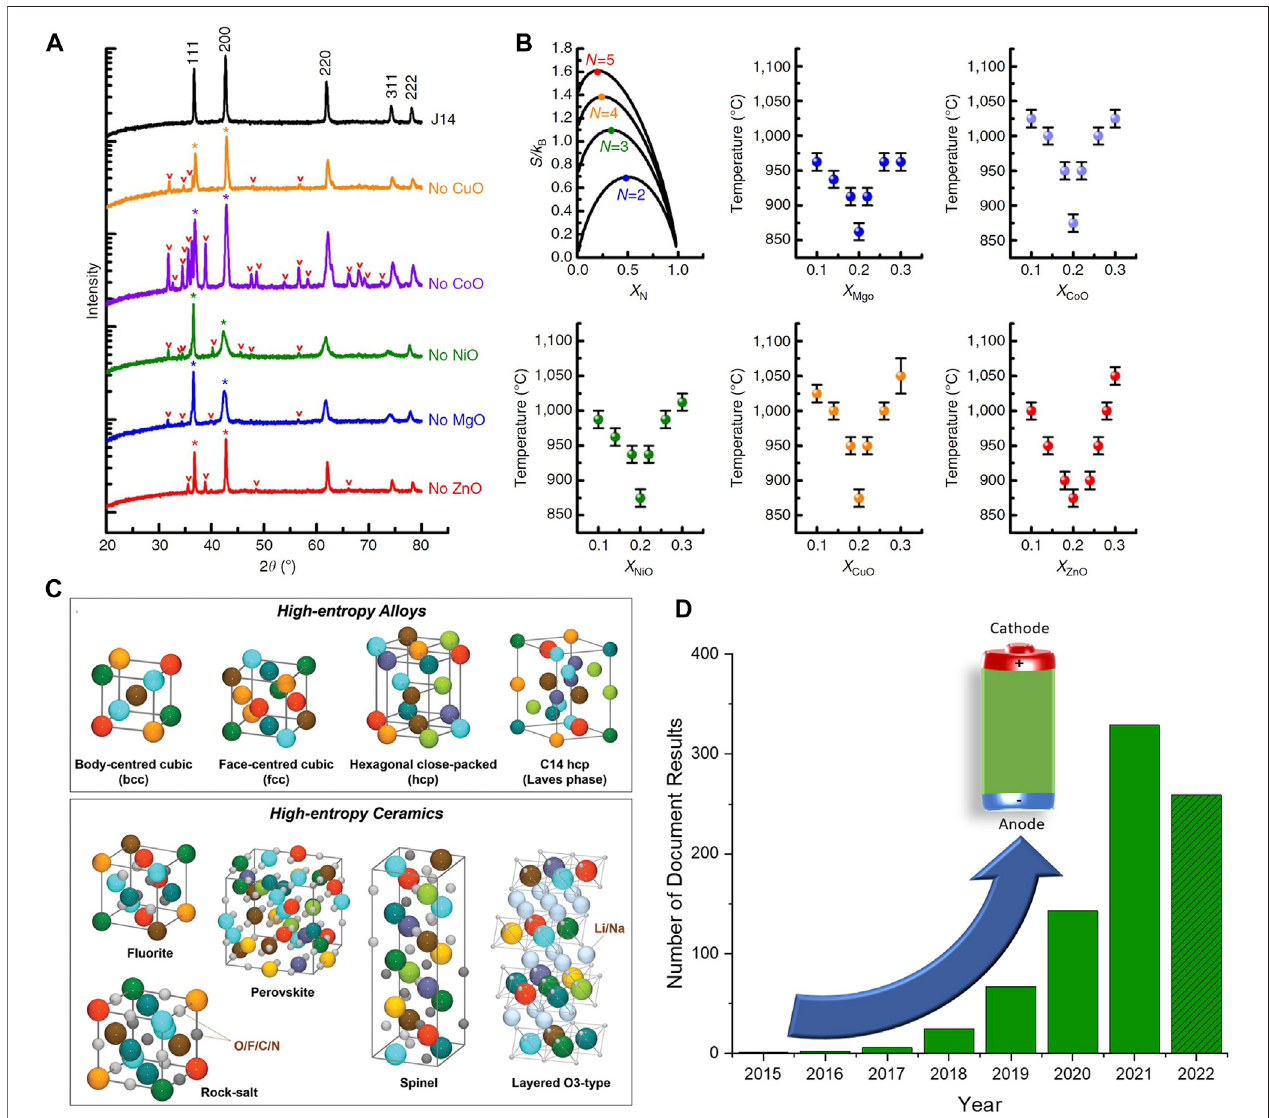
FIGURE1|(A) XRDofmulticomponentoxides (B) con fi gurationalentropyandphasediagramsofHEOelements(Rostetal.,2015). (C) commoncrystalstructures for HEAs and HEOs (Ma et al., 2021). Reproduced under the terms of the CC BY license. (D) Rapid growth in publications on high-entropy materials for energy storage. Data was gathered from Scopus by searching for high-entropy oxides, anodes, or cathodes, and limiting the search to material science and energy. Please note data from 2022 includes only